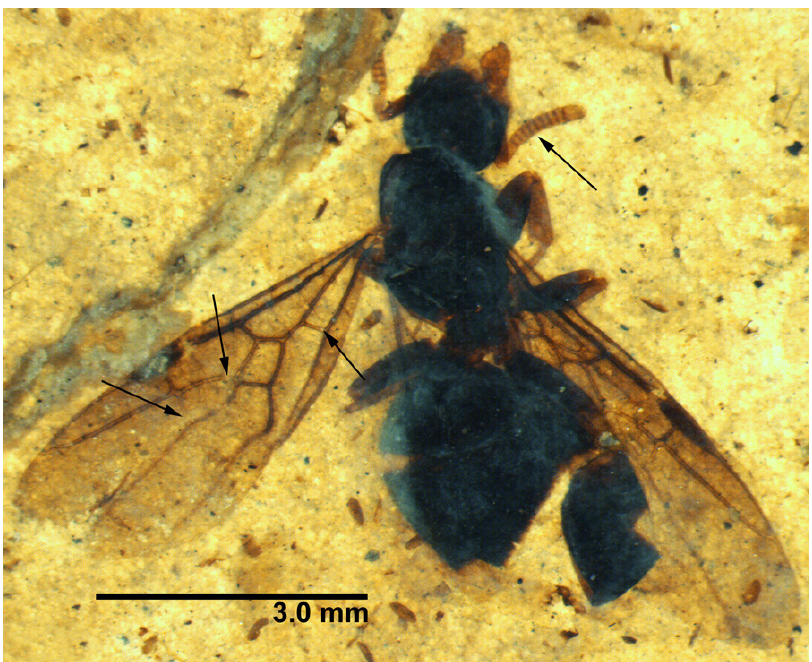
Fig 3 . Holotype queen, Ktunaxia jucunda (USNM# 609585). Arrows on wings indicate fenestrae present; arrow on antennae indicates the stocky, 10-segmented